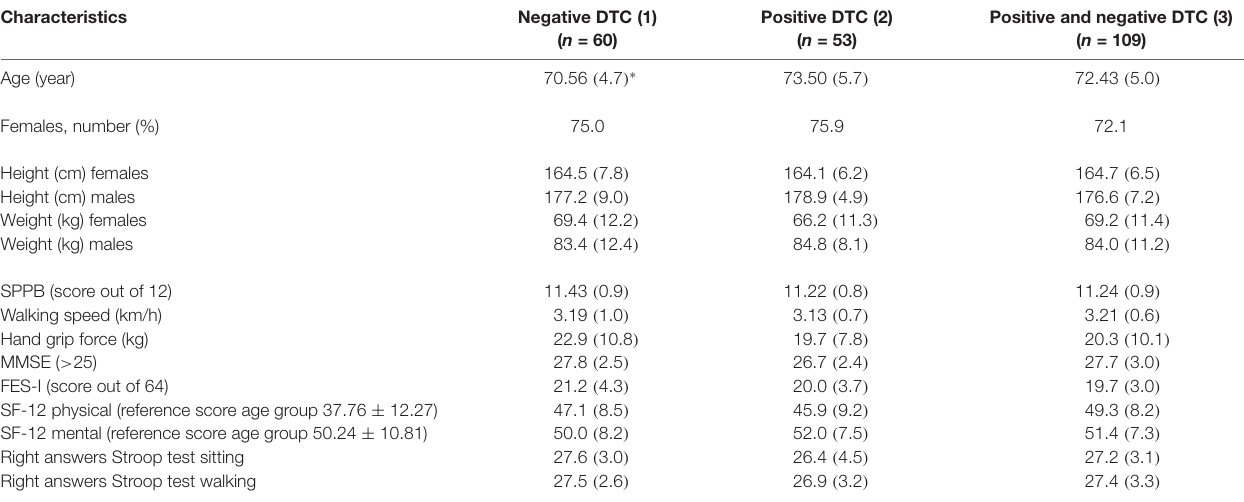
TABLE 1 | Mean (SD) or number (%) of the groups for the demographic characteristics of N = 222 participants at baseline.